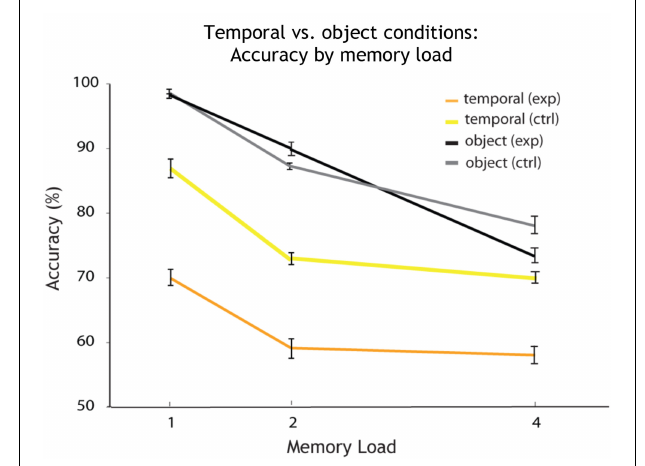
FIGURE 5 | Accuracy by memory load for single feature temporal vs. object conditions. Overall accuracy (percentage correct) for every memory load (1, 2, and 4 auditory objects presented within a sequence). The plot shows how accuracy decreases with an increase in memory load for each condition. Shown in orange are the results for the single feature temporal condition. Temporal is the relevant and spectral the irrelevant feature varied at random. In yellow: again temporal is the relevant feature, but the irrelevant spectral feature is held constant (temporal control condition). The results for the object condition are shown in black (the probe changes on both features on change trials). The results for the object control condition (the probe changes by a single feature on change trials) are shown in